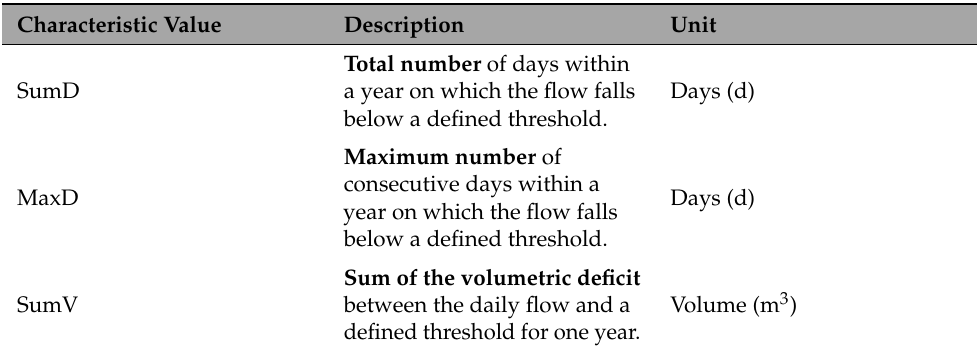
Table 3. Low flow characteristic values